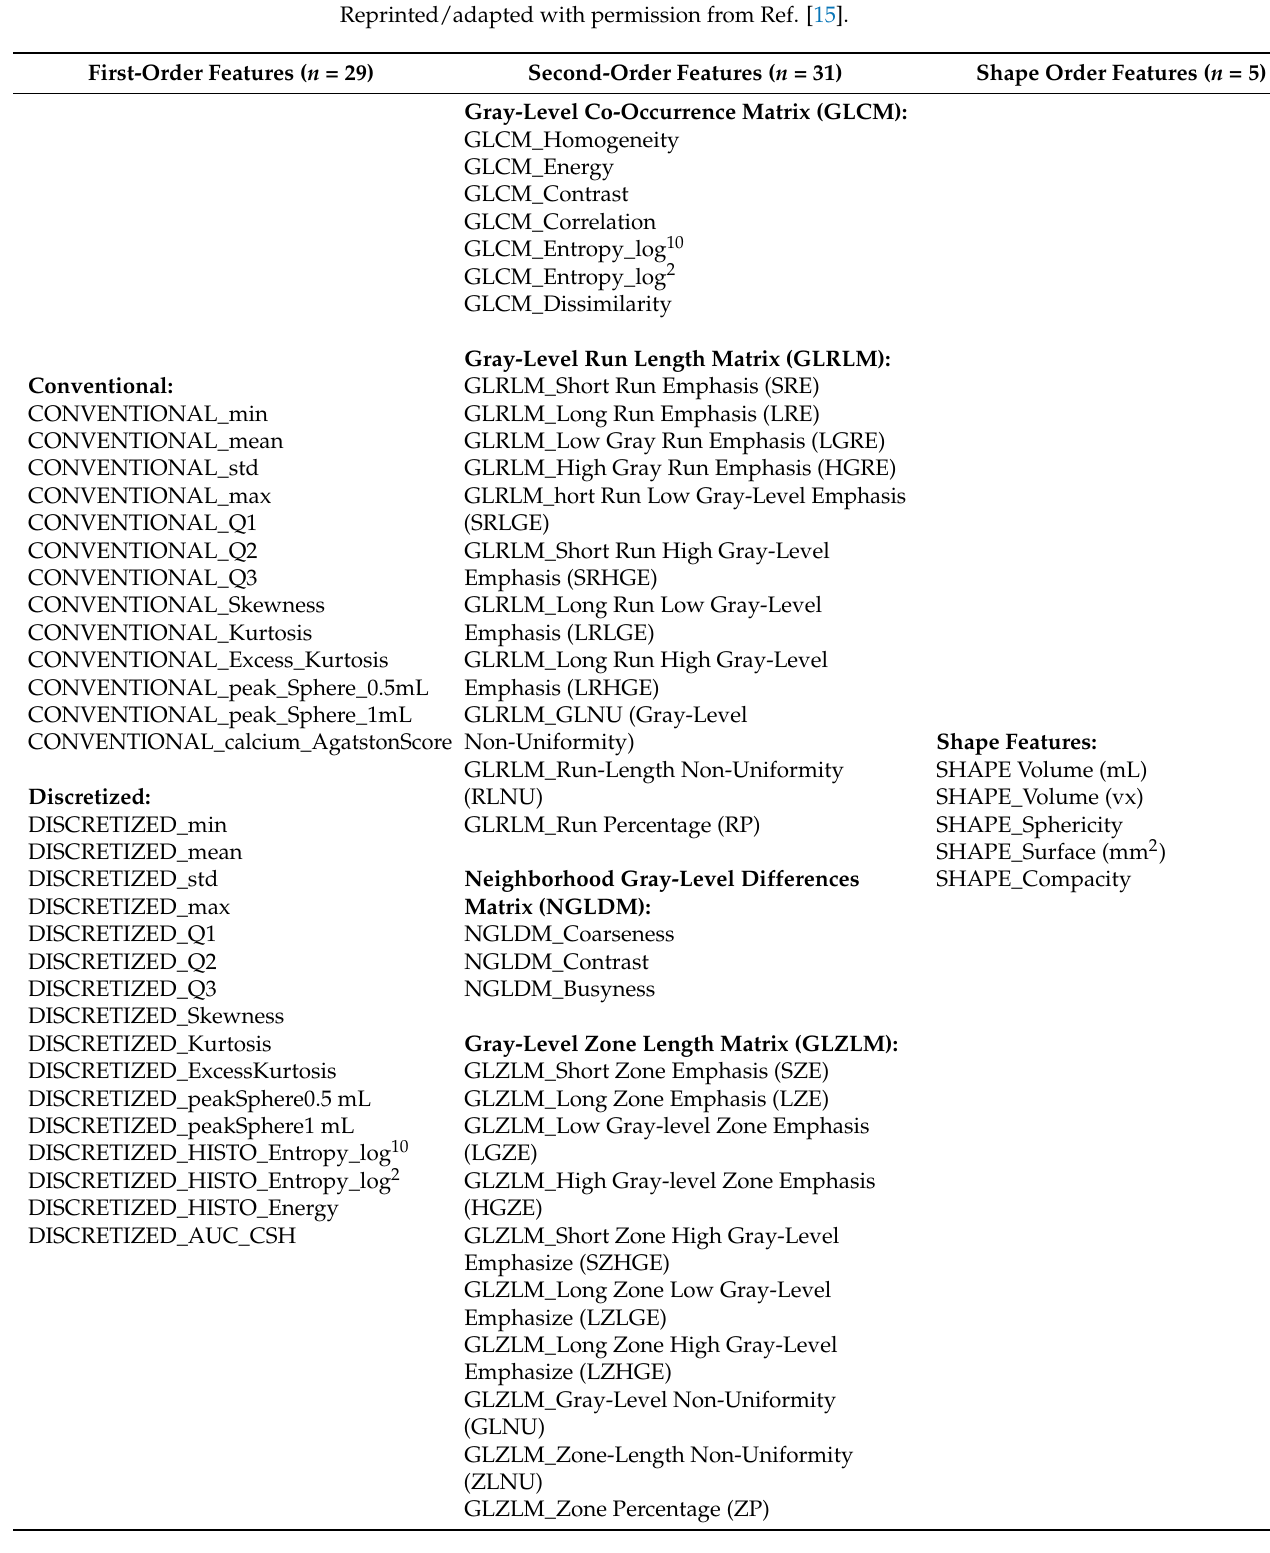
Table 2. List of first-order features ( n = 29), second-order features ( n = 31), and shape features ( n = 5). Reprinted/adapted with permission from Ref.